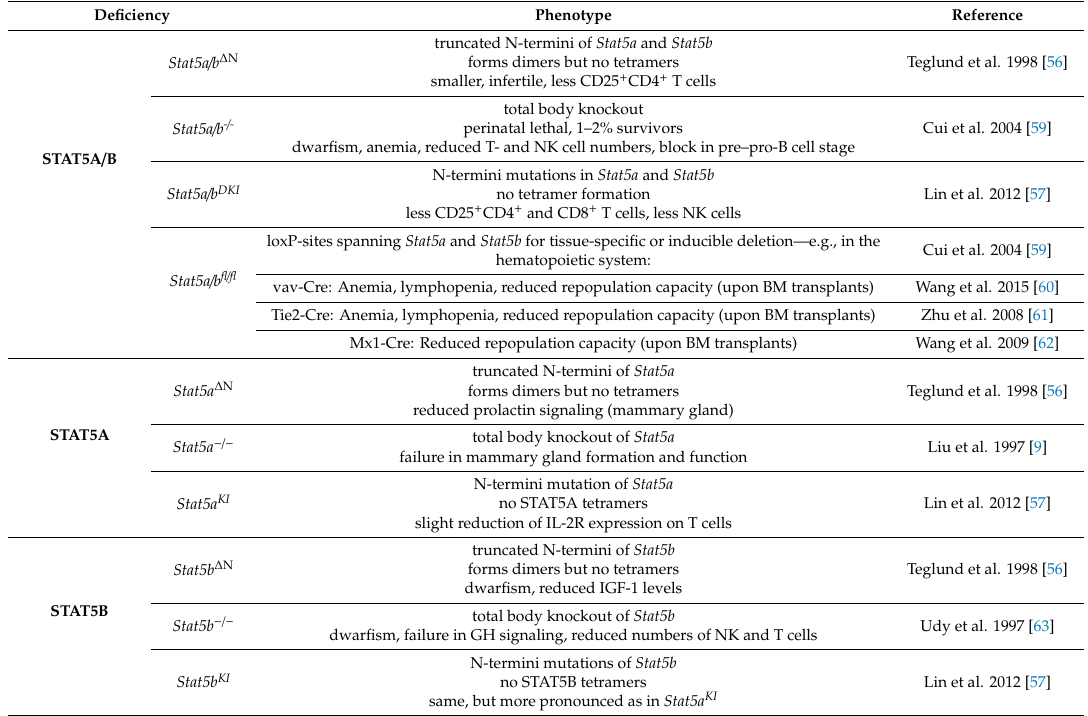
Table 1. Stat5a / b -deficient mouse